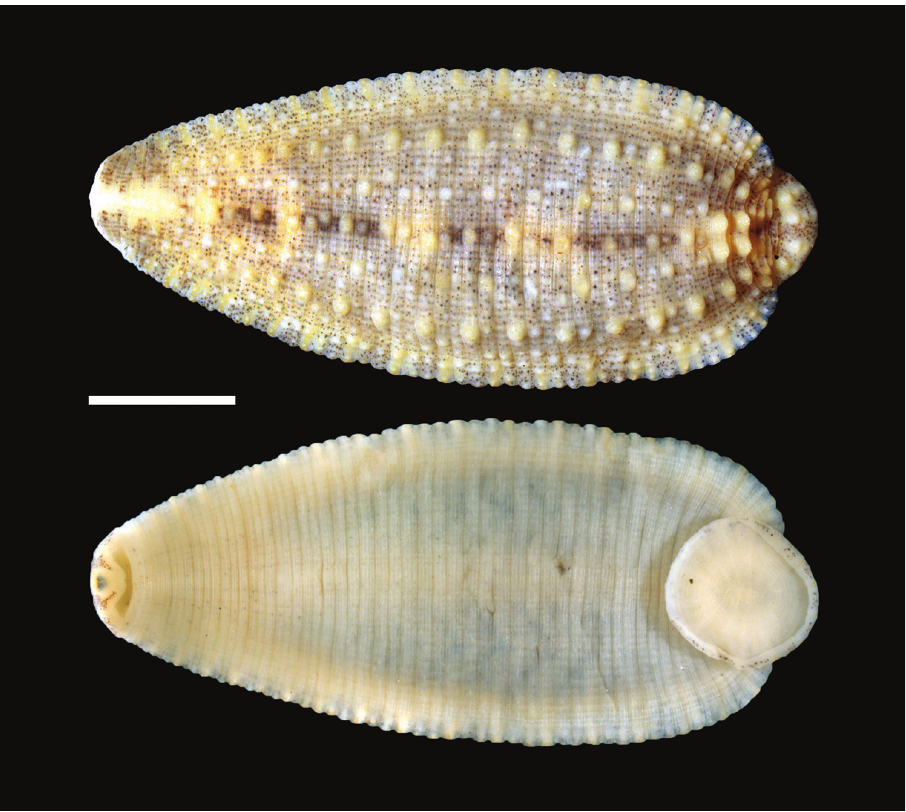
Figure 1. Holotype specimen of Placobdella siddalli Richardson & Moser, YPM IZ 083857 A Dorsal surface B Ventral surface. Scale bar: 2